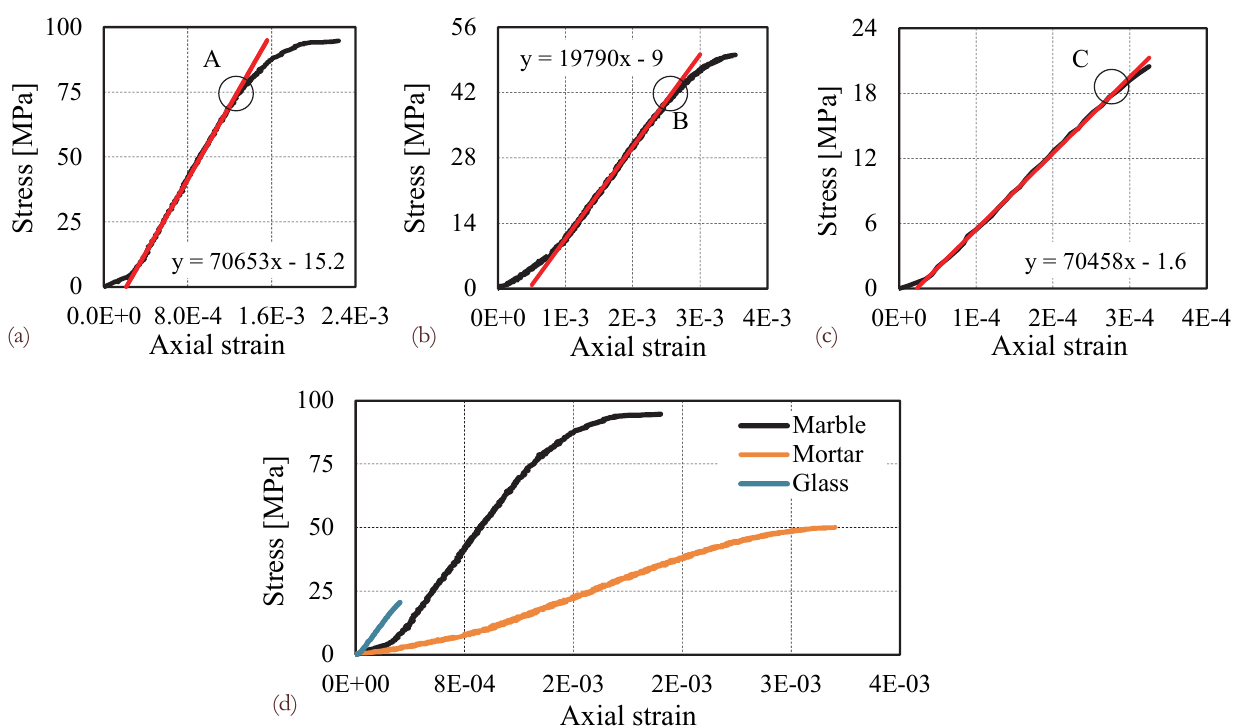
Figure 2: Typical stress-axial strain curves for (a) marble, (b) mortar and (c) glass specimens. (d) The three aforementioned curves together for comparison reasons.